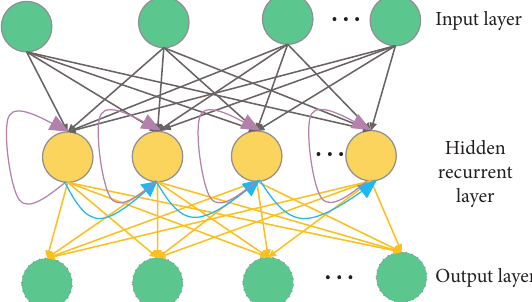
Figure 7: Recurrent neural network